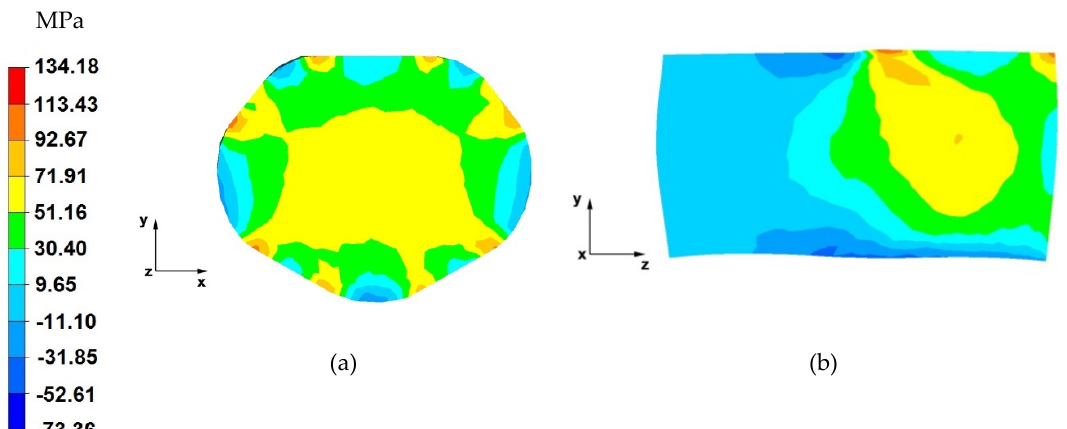
Figure 12. Distribution of the hydrostatic pressure of the AZ 91 alloy forging, deformed in the second pass with 25% reduction in trapezoid and diamond anvils: ( a ) on the cross-section, ( b ) on the longitudinal section.